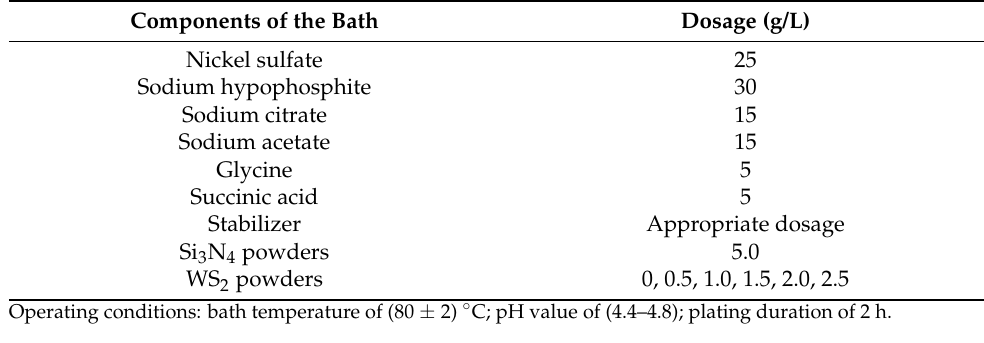
Table 1. Components of the electroless plating bath.